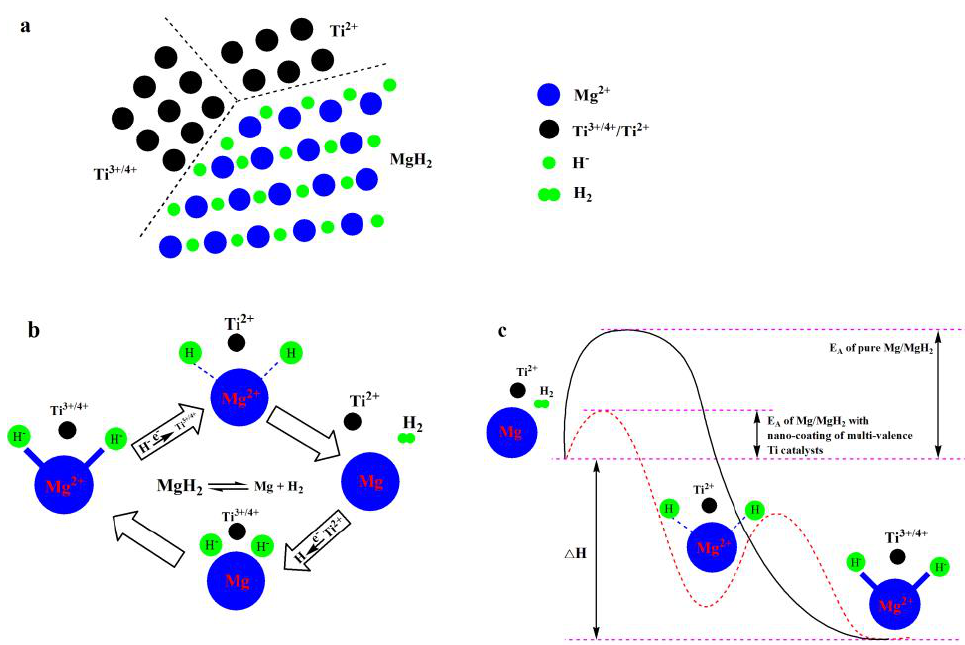
Figure 6. ( a ) Interfaces with high and low valence Ti among MgH 2 , ( b ) electron transfer between Mg 2+ and H − , and ( c ) schematic diagram of catalytic mechanism in de-/hydrogenation of Ti based multi- valence coated MgH 2 . Adapted with permission from [52], Copyright RSC, 2013.